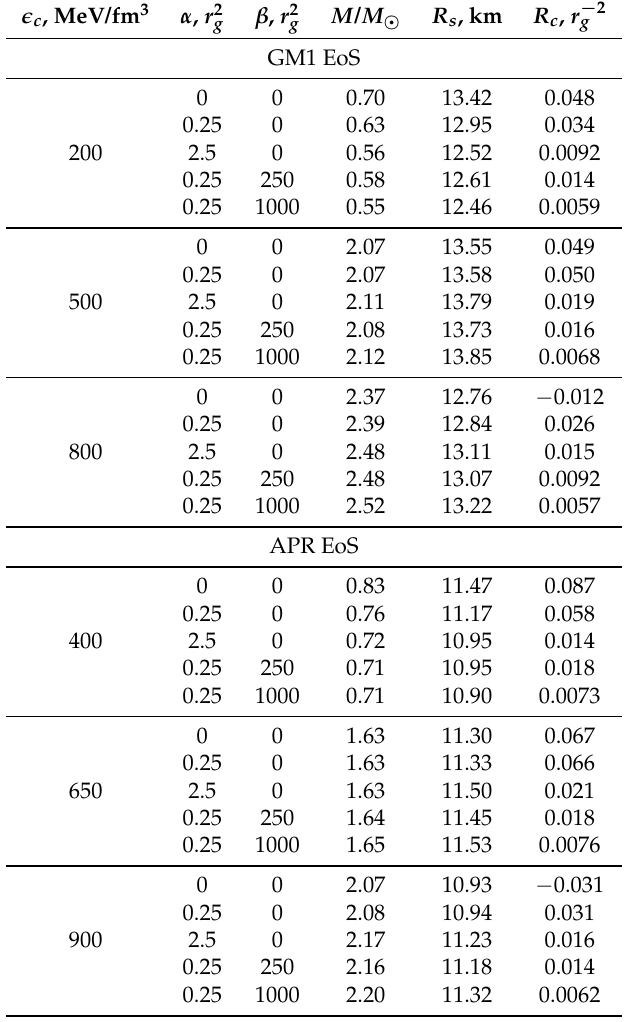
Table 1. Parameters of compact stars (masses and radii) in general relativity ( α = β = 0), simple R 2 -gravity ( β = 0) and for R 2 -gravity with an axion field for some values of central energy density using two EoS. In the last column, the corresponding values of curvature in the center of star are